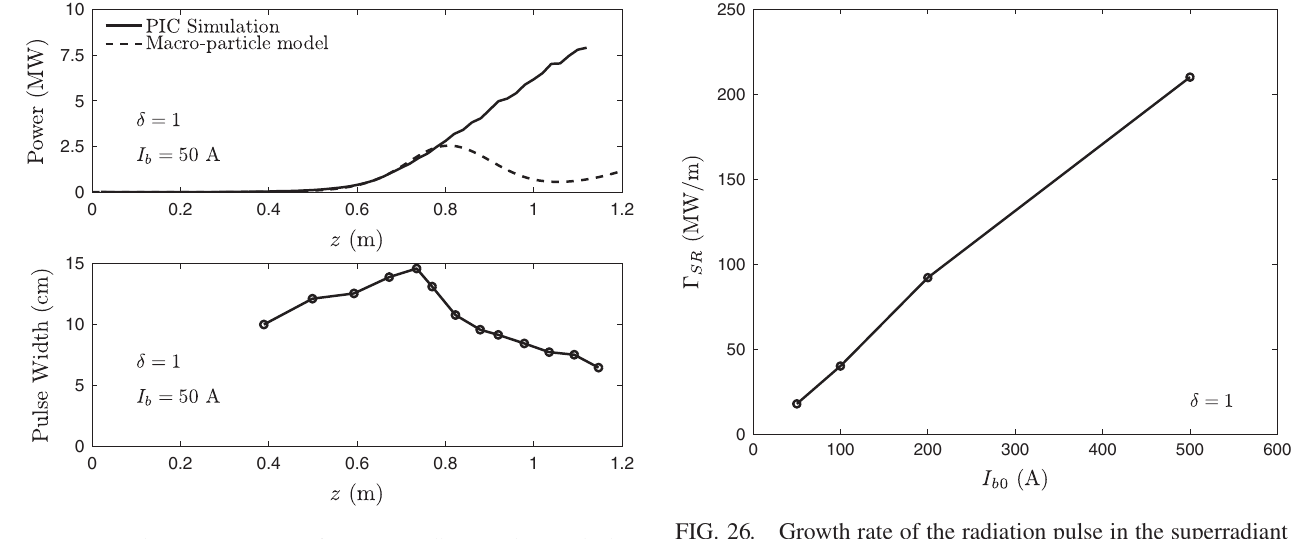
FIG. 24. Microwave power for superradiant pulse and the steady-state result for a 50 A beam with (cid:1) ¼ 1 . The pulse width decreases as the pulse enters the superradiant regime.